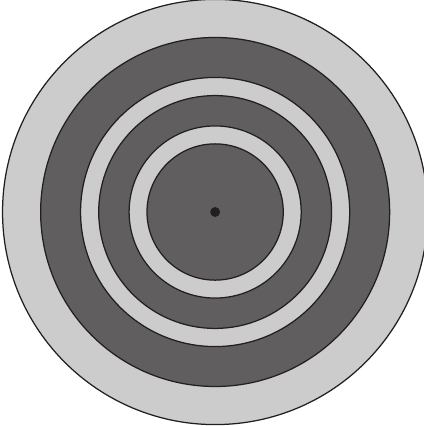
Figure 1: A monopolar patch antenna with a circular patch, circular ground plane, and two coupled metal rings [7]. The dot point indicates the coaxial probe pin. Dark gray monopole and light gray dielectric